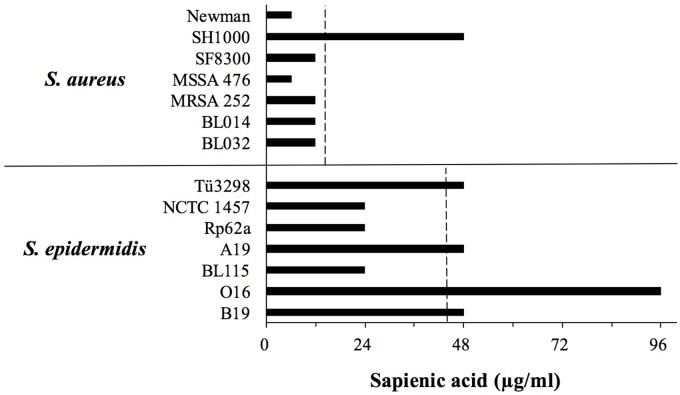
Sapienic acid minimum inhibitory concentration (MICs) of S. aureus and Staphylococcus epidermidis strains. MICs were determined using the broth microdilution method. MICs are the lowest concentration found to inhibit growth. The dotted line shows the mean MIC of each species.